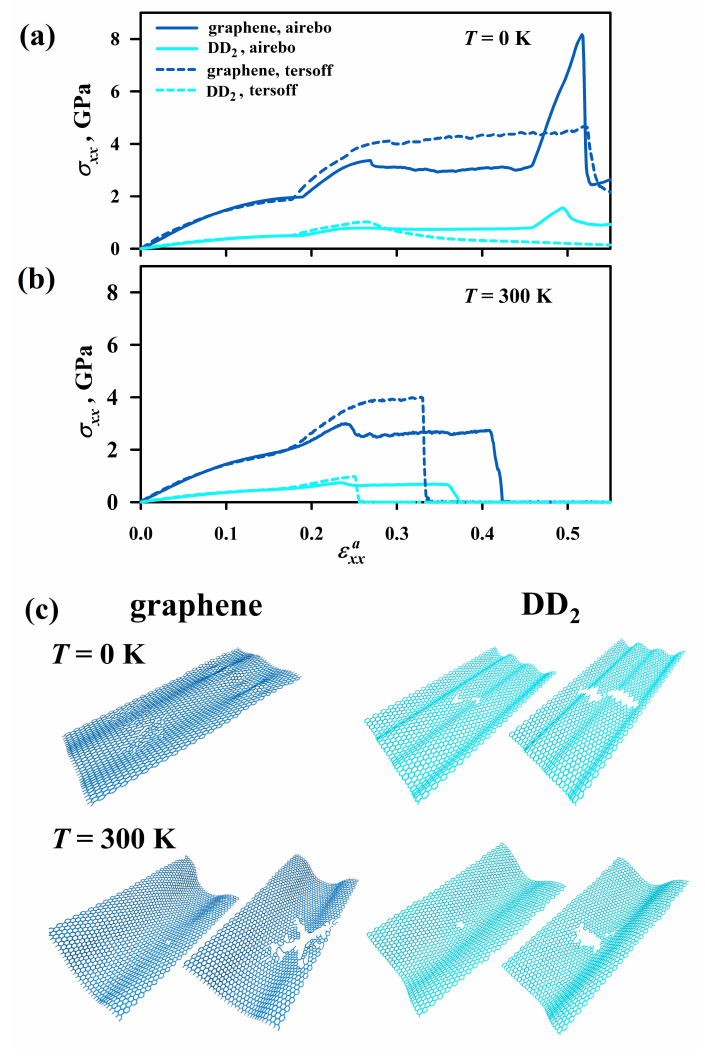
Figure 4. ( a , b ) Stress-strain curves for graphene and graphene with DD 2 under tension along armchair ( a ) and zigzag ( b ) direction at 0 and 300 K. ( c ) Snapshots of graphene after a